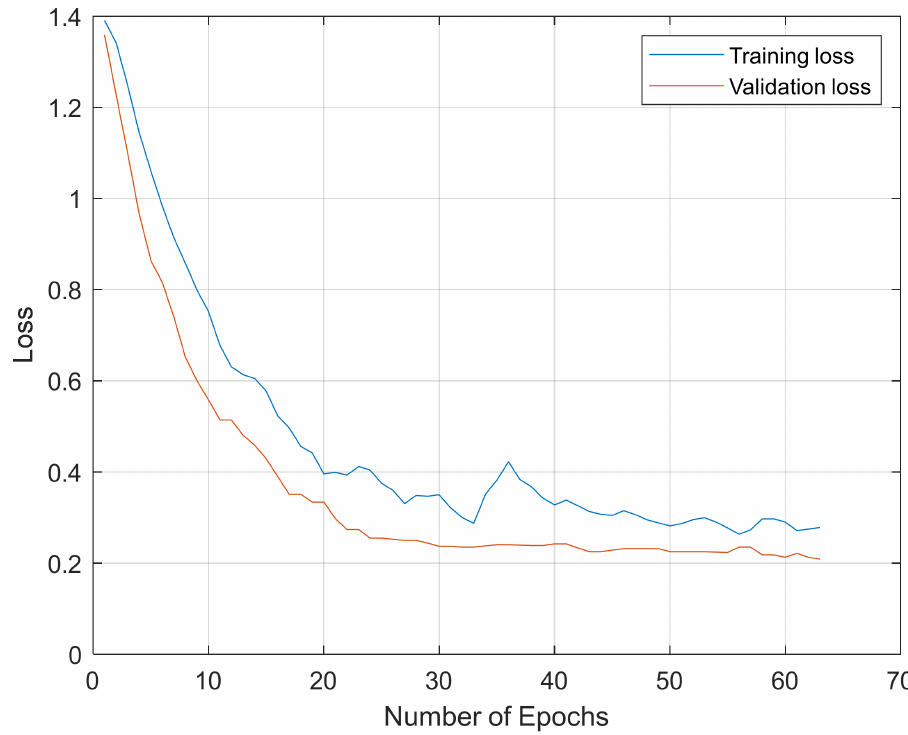
Figure 6. Training Loss and Validation Loss of Model-2.